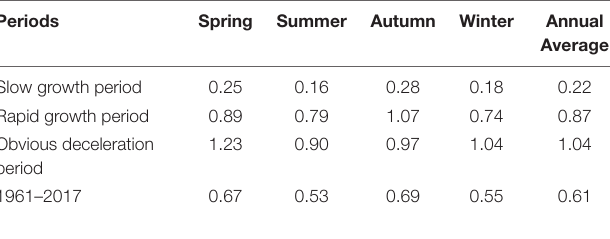
TABLE 3 | The UHI intensity in spring, summer, autumn, and winter during different periods (unit: ◦ C).